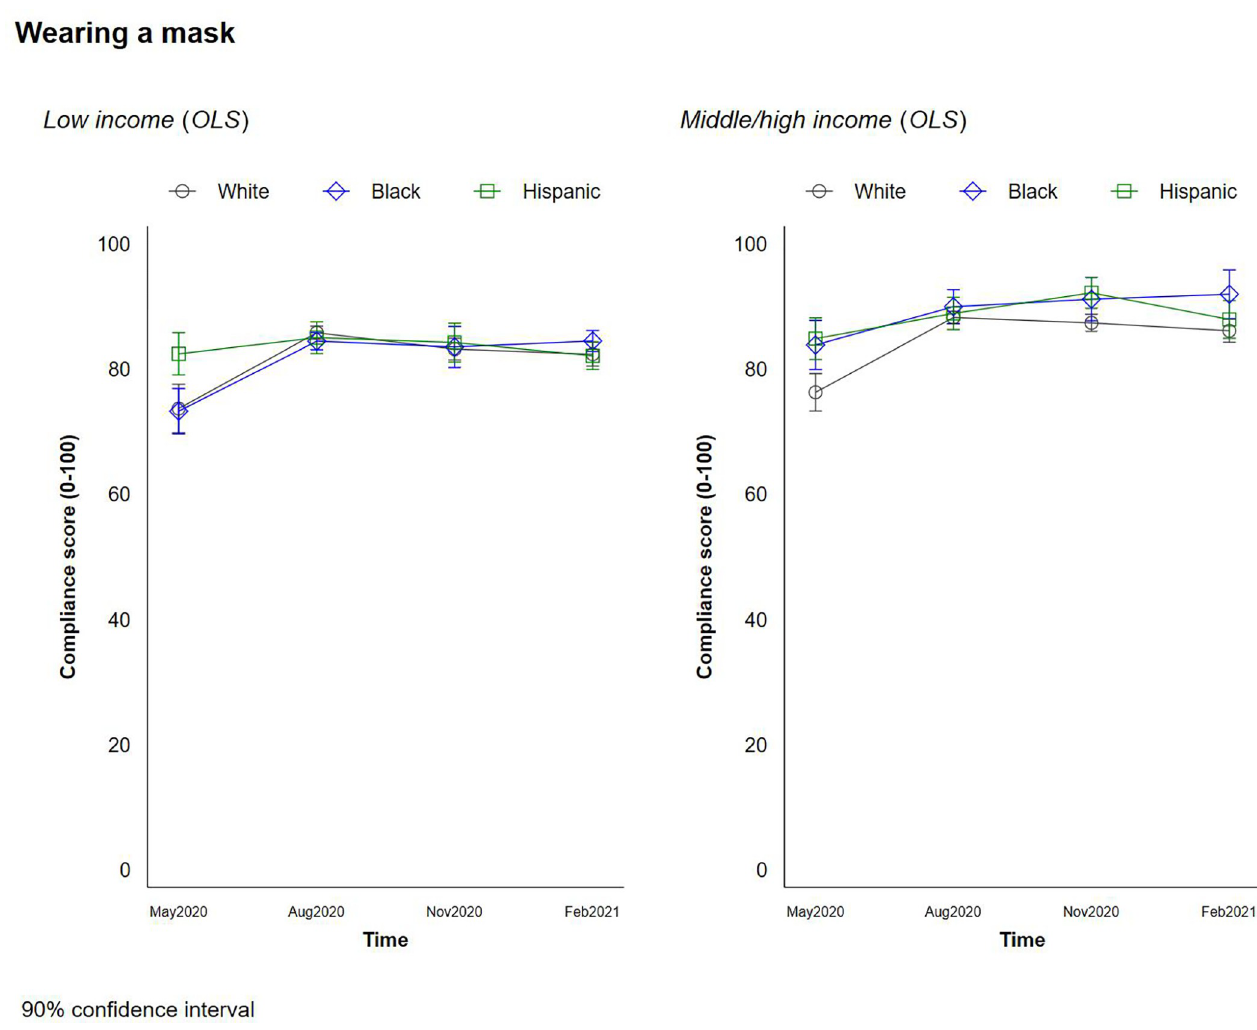
Fig 7. Changes in social distancing behaviors by race and income–wearing a